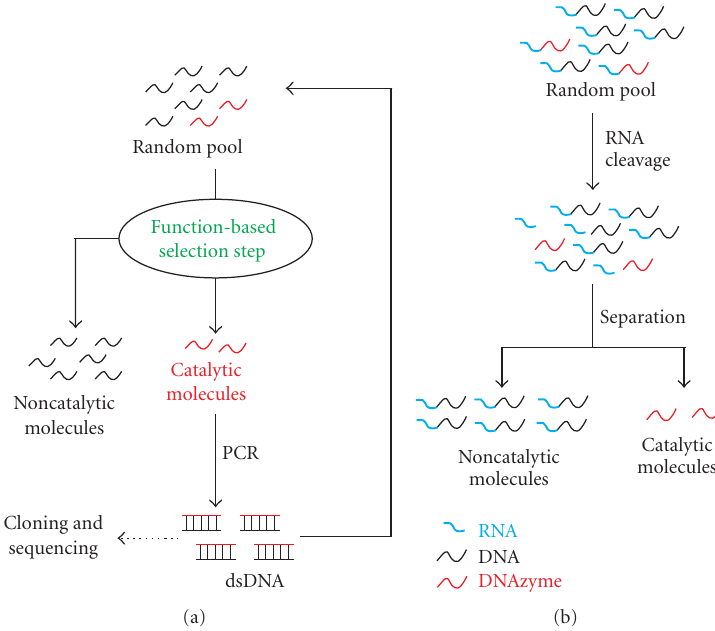
Figure 2: Deriving RNase DNAzymes by in vitro selection. (a) Schematic of isolating DNAzymes from a DNA pool. (b) Gel electrophoresis- based method for selecting RNase DNAzymes. For clarity, only the function-based selection step is shown.